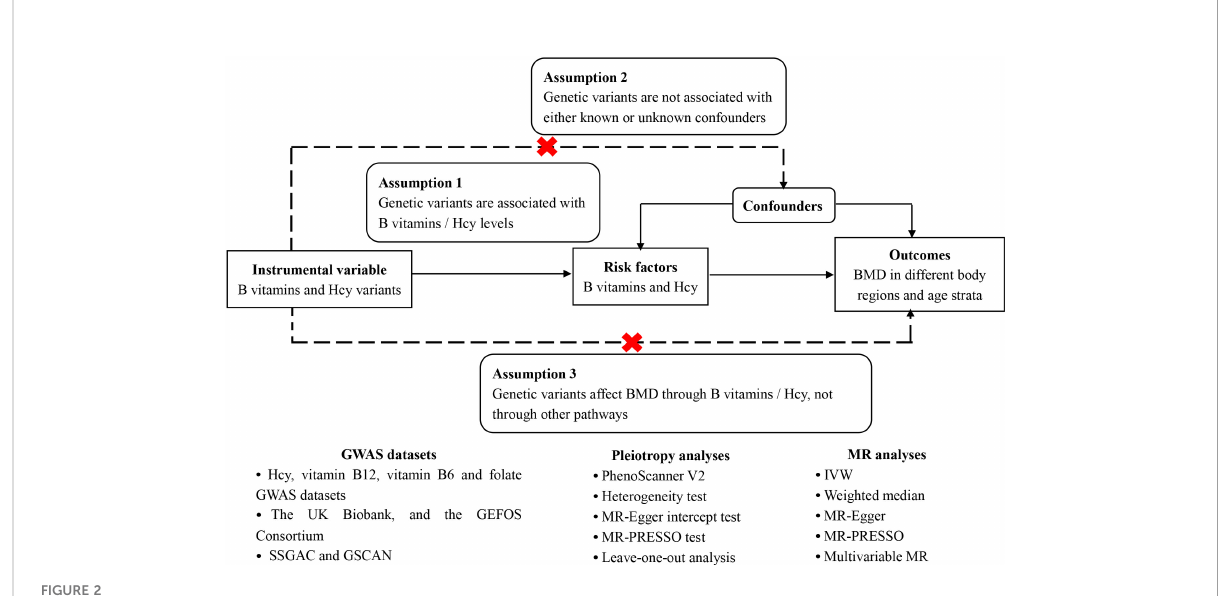
FIGURE 2 Schematic overview of the Mendelian randomization study